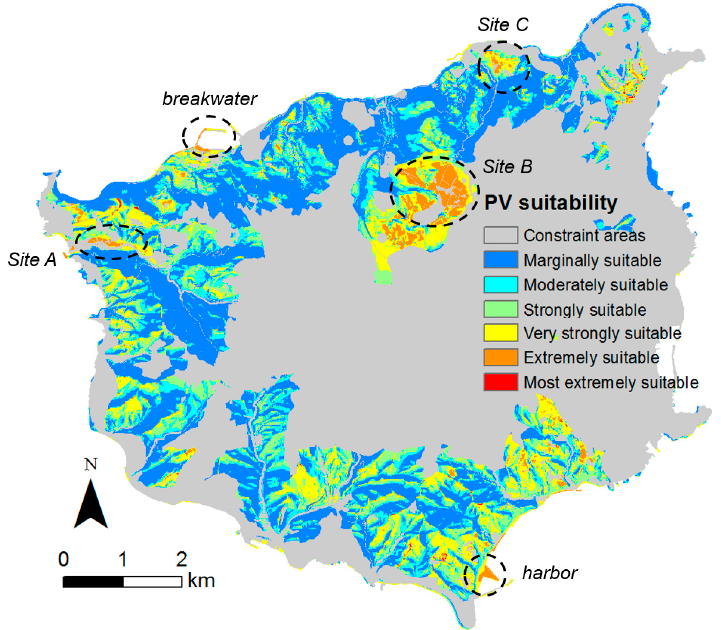
Figure 5. Suitability index (SI) for PV solar farm development on Ulleung Island.